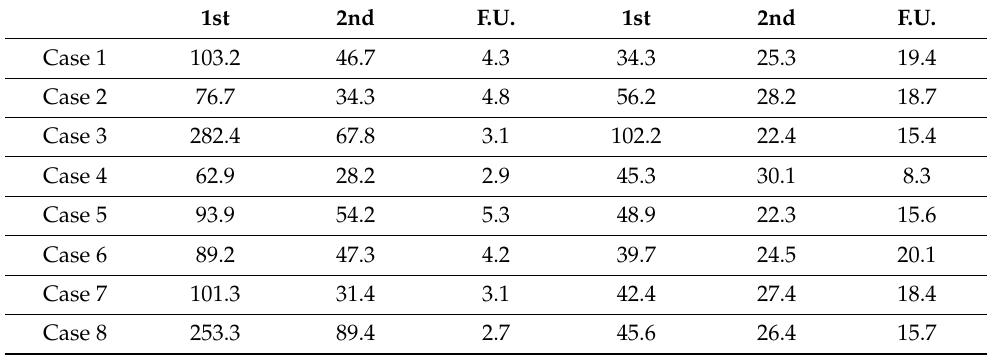
Table 5. Inflammatory markers CRP/ESR before first stage (1st), second stage (2nd) and follow-up